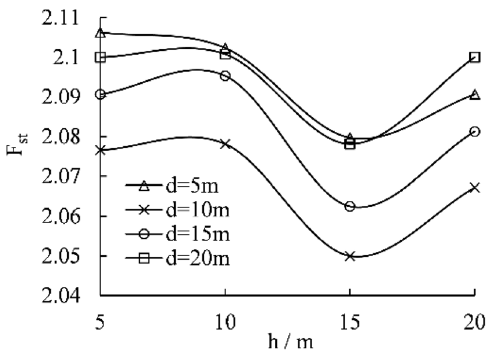
Figure 5. Relationship between safety factor and the length of vertical joints.